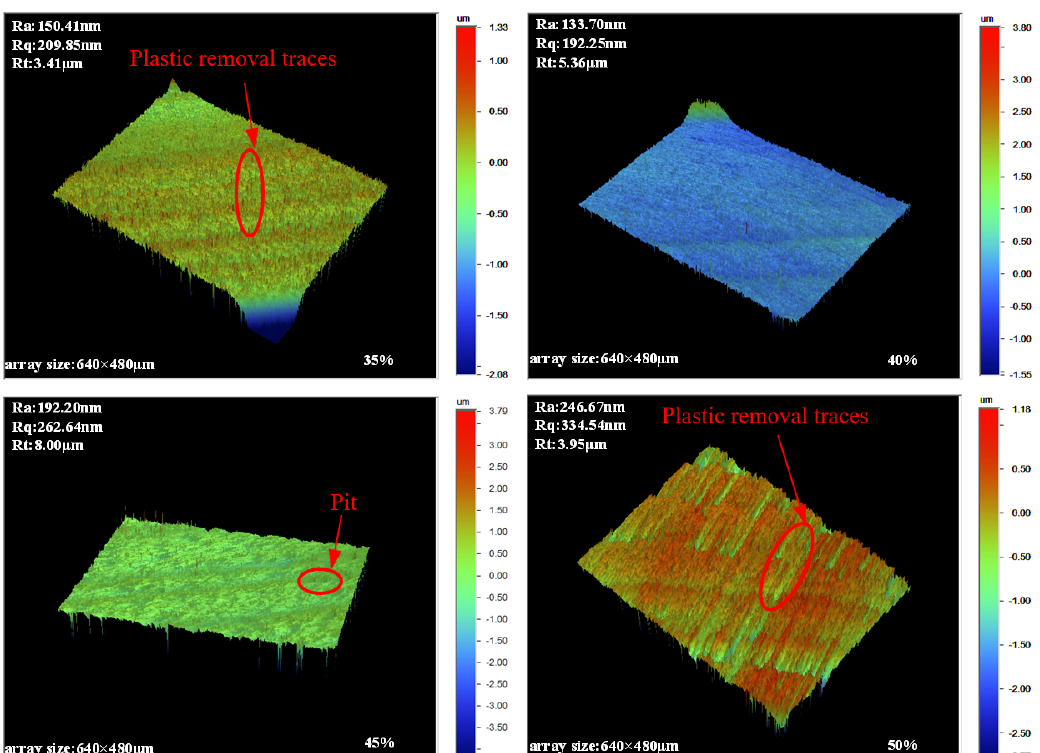
Figure 10. Microscopic appearance of samples with different magnetic particle contents.